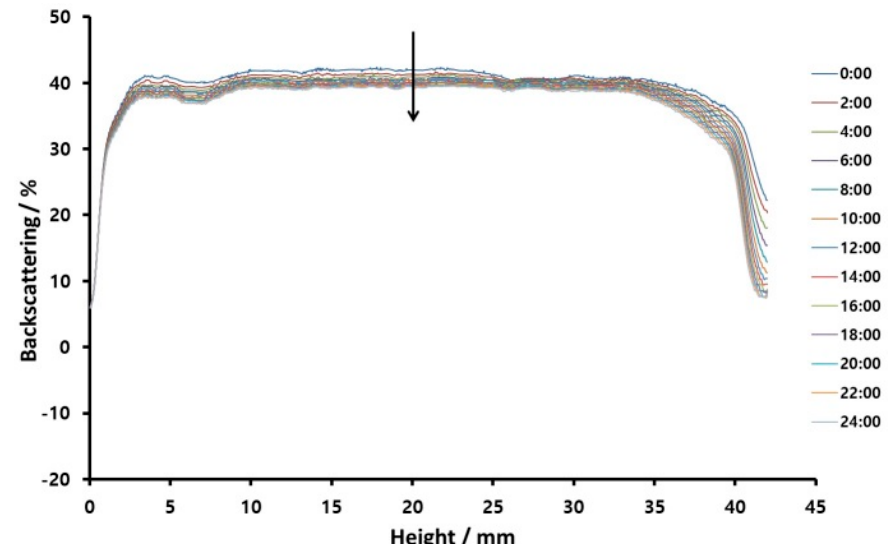
Figure 5. Change of backscattering of the Pickering high internal phase emulsions (HIPEs) over 24 h measured 48 h after HIPE preparation (particle 5 wt.%, PAAS 6 wt.%, internal phase 80 vol.%).